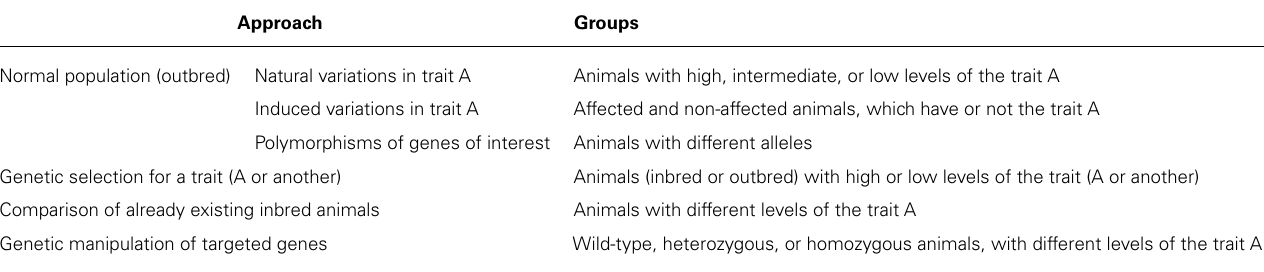
Table 1 | Different approaches for the characterization of individual differences. Approach